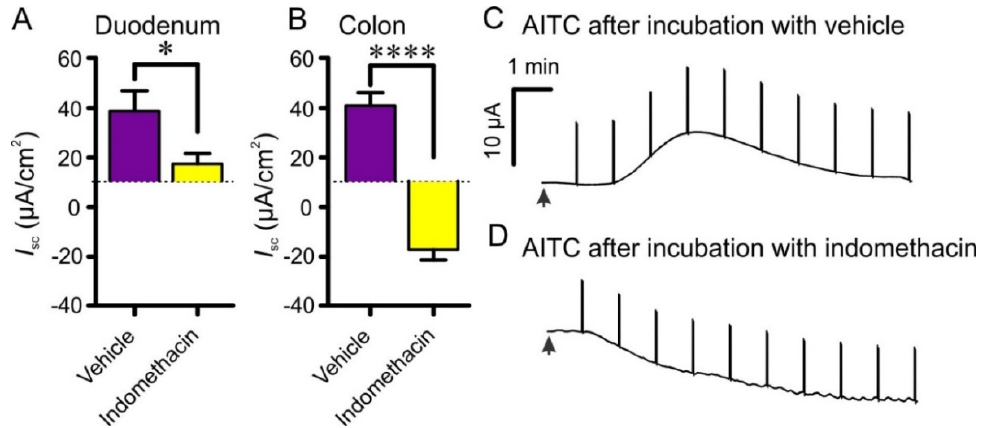
Figure 8. Effect of AITC (100 μ M) following a 20 min incubation with indomethacin (10 μ M) or its vehicle (5 μ L DMSO) on the mucosal and serosal side of duodenum ( A ) and colon ( B ) segments; Representative traces of the I sc following addition of AITC (100 μ M) to colon segments following a 20 min incubation with vehicle ( C ) and indomethacin ( D ). Arrowheads: AITC (100 μ M) added to